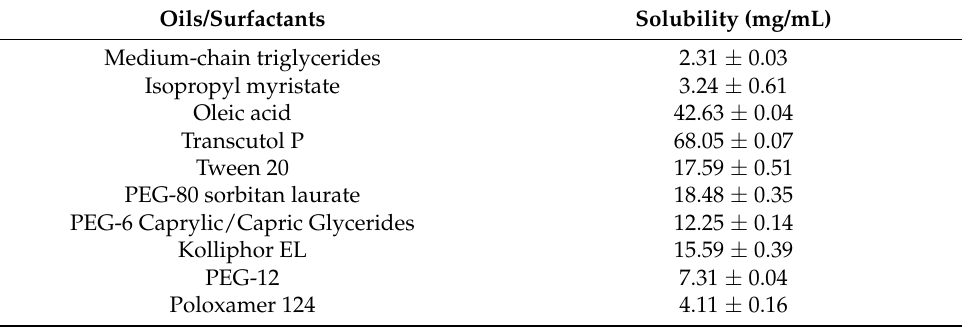
Table 1. Solubility of finasteride in various oils and